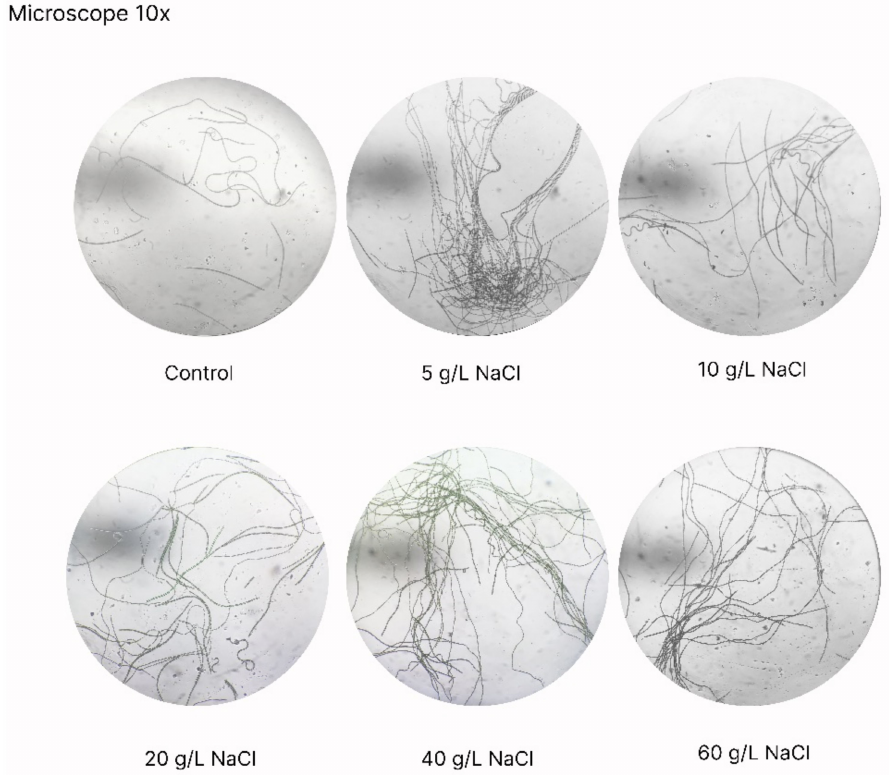
Figure 7. Microscopic appearance of A. platensis cultivated at various